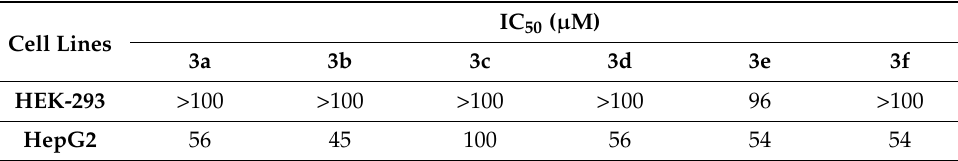
Table 2. IC 50 of the chalcones ( 3a – f